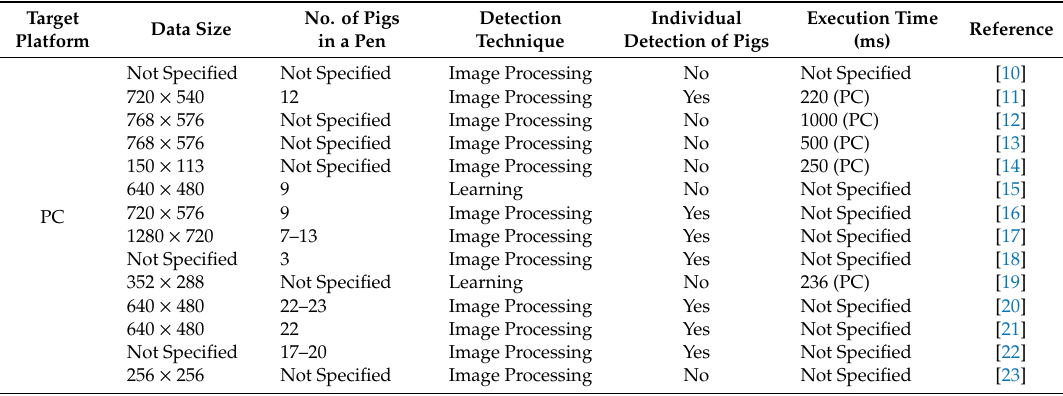
Table 1. Some of the recent pig detection results (published during